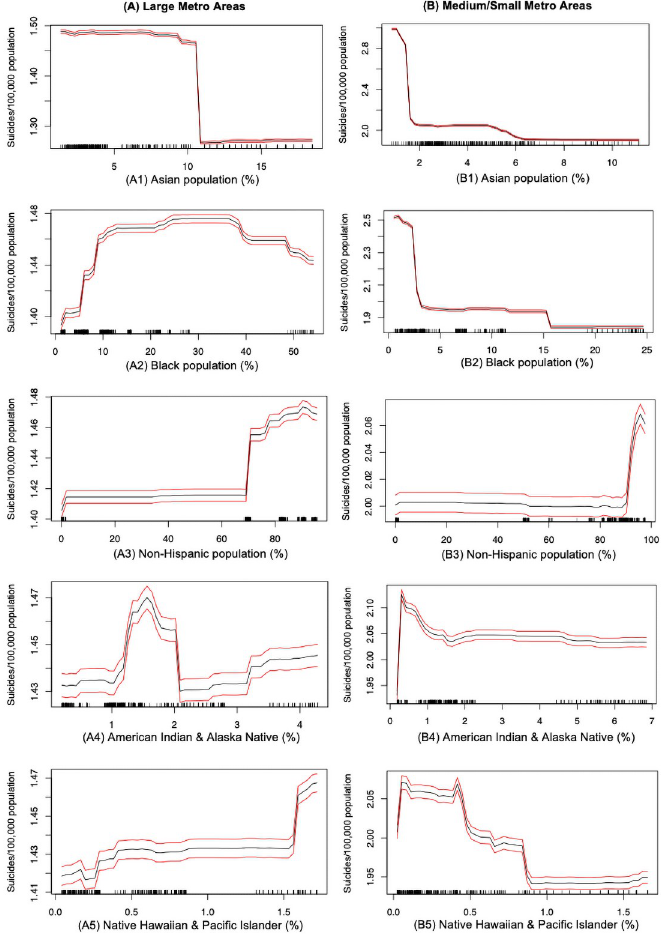
indicate the 95% confidence intervals.